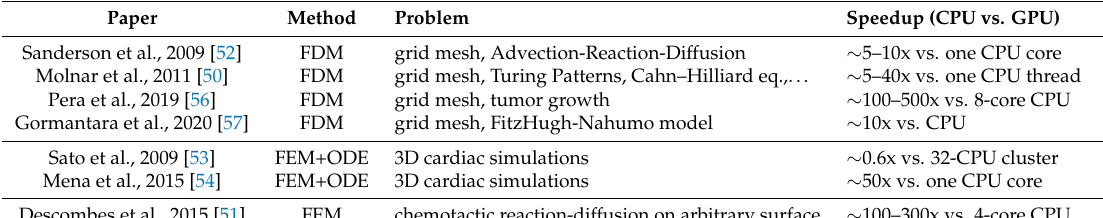
Table 1. Examples of representative works on GPU-accelerated resolutions of reaction-diffusion PDEs . These methods include Finite Difference Methods (FDM) and Finite Element Methods (FEM) [55]. For each study, we present a typical speed-up between CPU and GPU